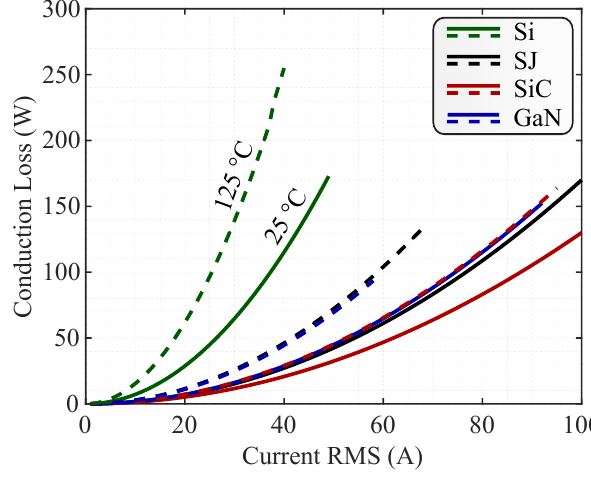
Figure 4. Conduction loss as a function of I RMS .